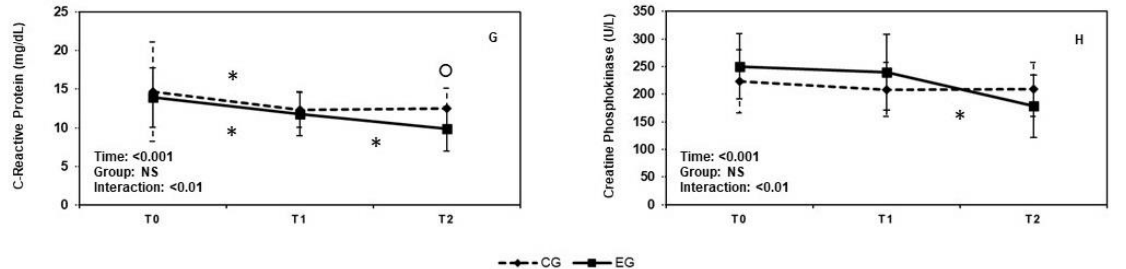
Figure 1. Line plots representing the results from mixed factorial ANOVAs on biochemical parameters in experimental group (EG) and control group (CG): ( A ) BMI, ( B ) glycemia, ( C ) total cholesterol, ( D ) LDL-cholesterol, ( E ) HDL-cholesterol, ( F ) triglycerides, ( G ) C-reactive protein, and ( H ) creatine phosphokinase. Note . * p < 0.001, ◊ p < 0.01, ○ p < 0.05; a T0 – T2 for both groups, p < 0.05.